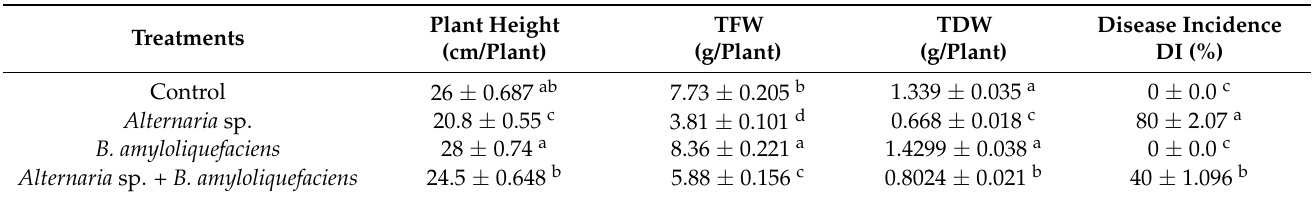
Table 6. The effect of B. amyloliquefaciens on pepper growth promoting traits and disease incidence (DI) (%) during Alternaria sp.